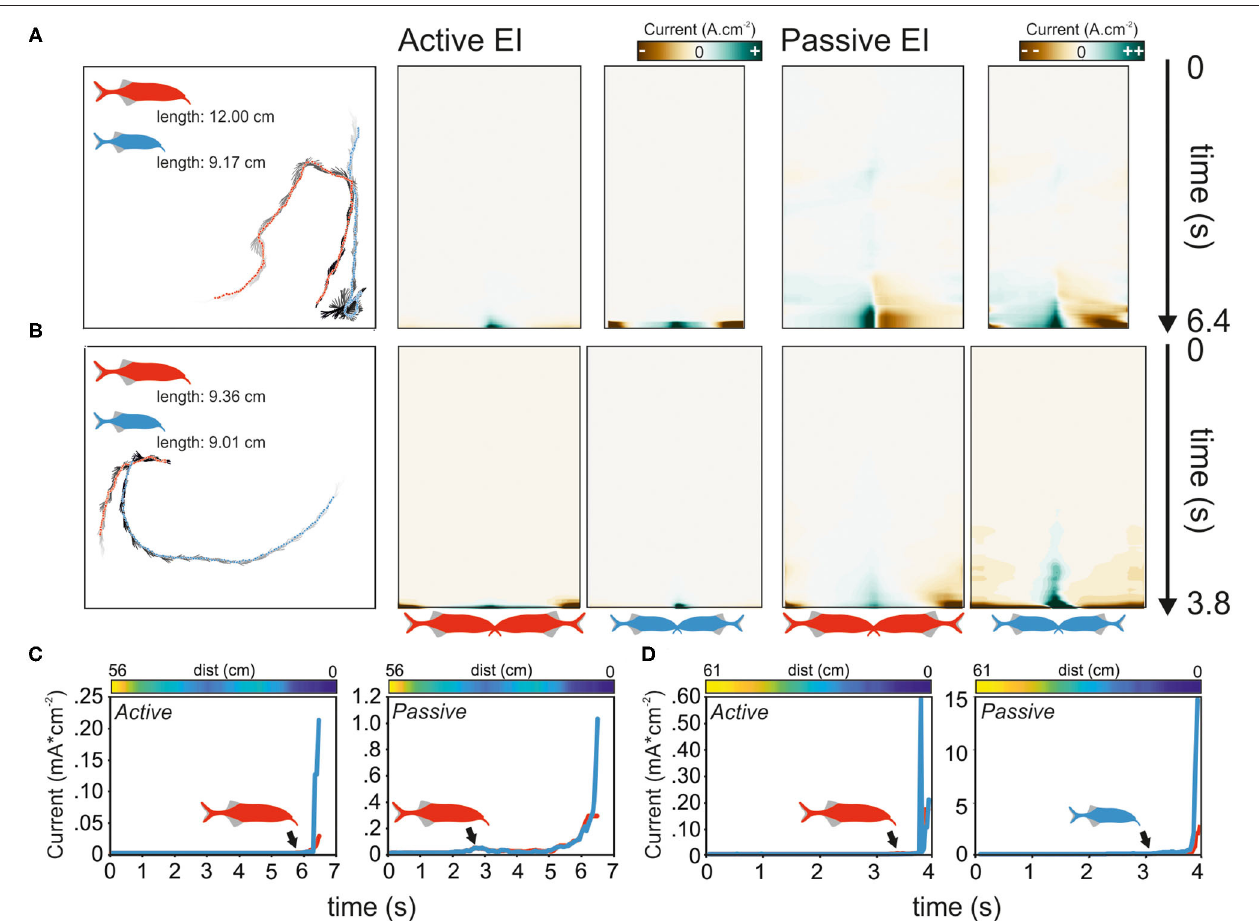
FIGURE 9 | Analysis of electrosensory input calculated for the initial approach phase during the agonistic encounter of dyads of Gnathonemus petersii . (A,B) Left: approach trajectories of two fish of large (A) and small size differences (B) . Points indicate the fish positions and gray lines indicate their orientations. Time from start to the first physical encounter is depicted by the gray gradient of the orientation labels (light gray = start). Middle: color-coded RMS of the active EIs of the sequences are shown on the left. Here, zero on the y-axis indicates the start of the experiment (see black arrow), and the images end with the first contact. Right: same as data on the left but for passive EIs. (C,D) The maxima of active (left) and passive (right) EI of both fish are plotted against time. The distance between individuals is shown in the color-coded bar above the plot. Blue colors indicate close distances, whereas yellow colors represent larger distances. Note that in C the distance does not constantly reduce over time. The black arrows indicate the time point at which the EI of both fish start to diverge. The fish perceiving the strongest EI is shown in a color-coded fashion. The data in C corresponds to the approach depicted in (A) , whereas the data in (D) refer to the approach depicted in (B) . Red and blue symbols represent the large and small fish,